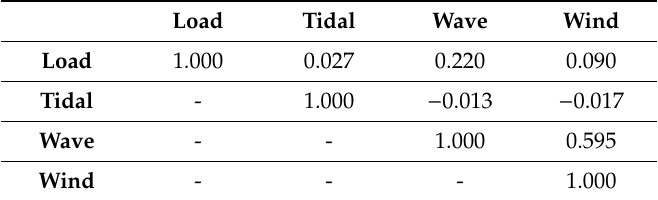
Table 1. Correlation coe ffi cients (r) between load and generation